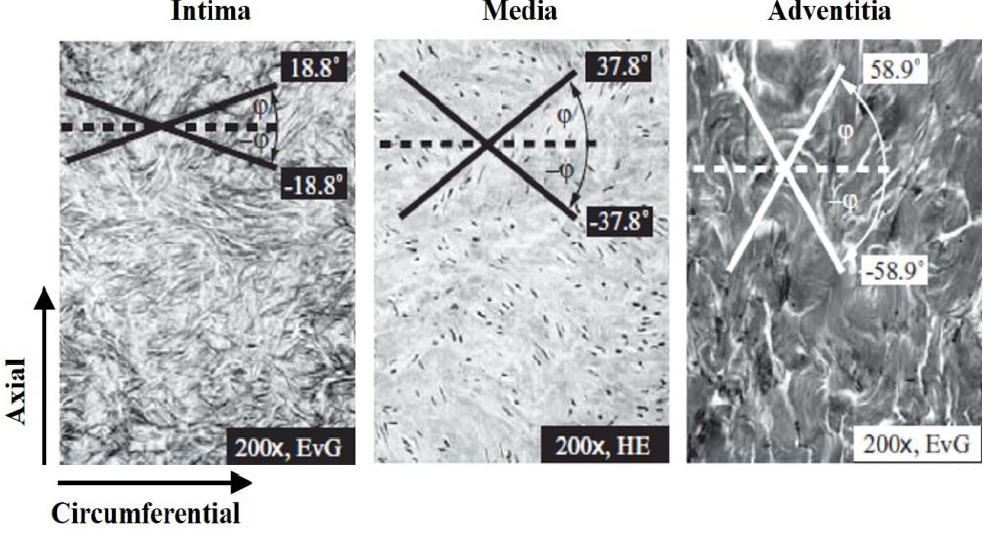
Figure 3. Images of an intimal, medial, and adventitial strip with circumferential orientation [21].